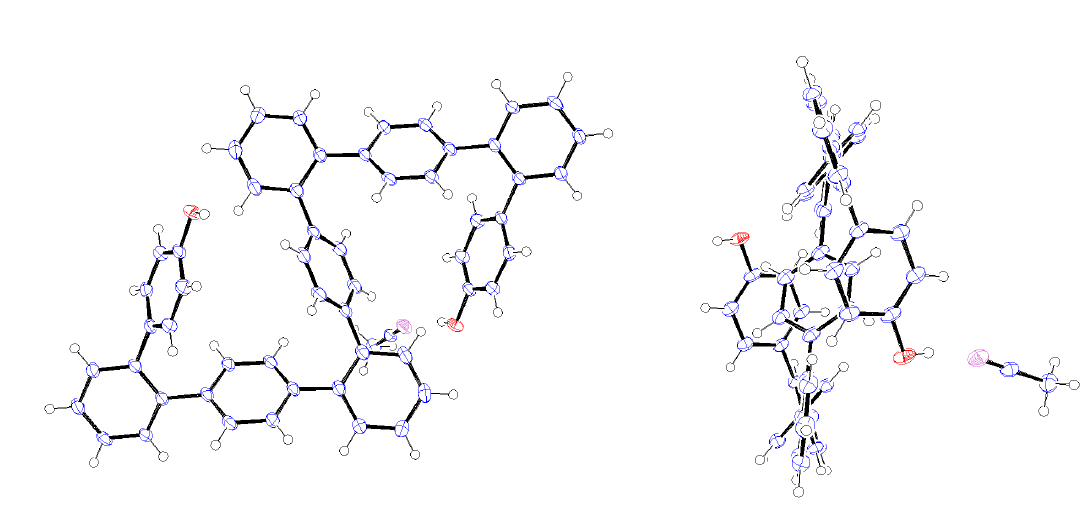
Figure 1. ORTEP representation (50% ellipsoid probability) of the X-ray structure of 12 ·2CH CN. Only one CH CN molecule is shown. Left, front view; Right, side 3 3